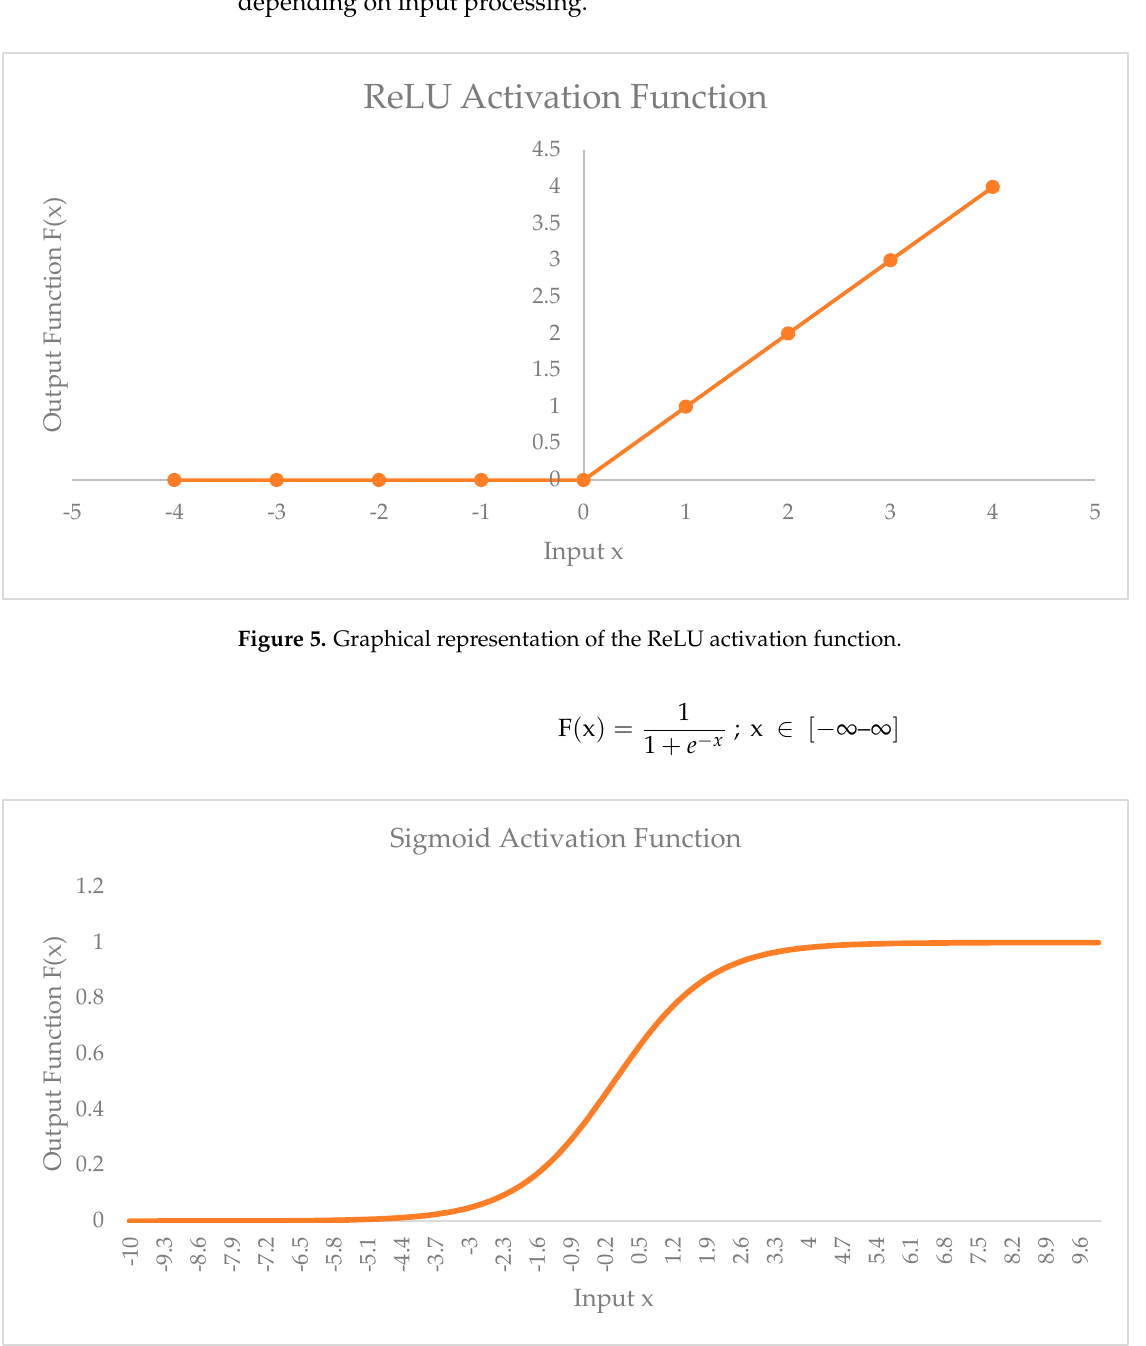
Figure 6. Graphical representation of the sigmoid activation function.